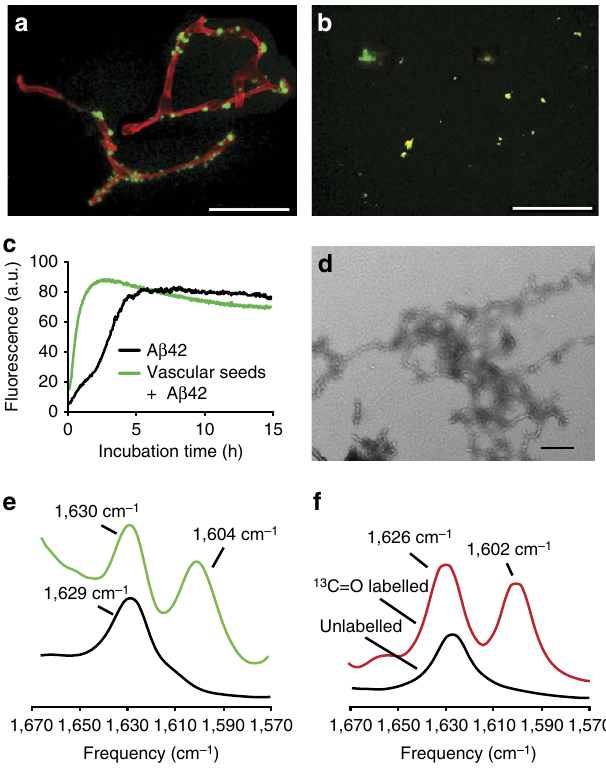
Figure 7 | Anti-parallel b -sheet structure in vascular amyloid. Capillaries isolated from aged Tg-SwDI mouse brain ( a ) and capillary amyloid deposits after digestion and removal of the capillaries ( b ) stained for fibrillar amyloid using thioflavin S (green) and immunolabelled for cerebral blood vessels using an antibody to collagen IV (red). Scale bars, 50 m m. ( c ) Thioflavin T fluorescence showing rapid fibril growth of A b 42 in the presence of microvascular seeds (green). ( d ) TEM of A b fibrils obtained by adding 1- 13 C Gly33-labelled A b to microvascular amyloid seeds. Scale bar, 50nm. ( e ) FTIR spectra of A b fibrils formed using soluble wild-type A b 42WT labelled with 1- 13 C Gly33 either added to seeds from microvascular amyloid deposits (green) or grown in solution without seeds (black). ( f ) FTIR spectra of KLVFFAE fibrils with (red) or without (black) 1- 13 C labelling at Leu2. (Supplementary Fig. 1). TEM, transmission electron